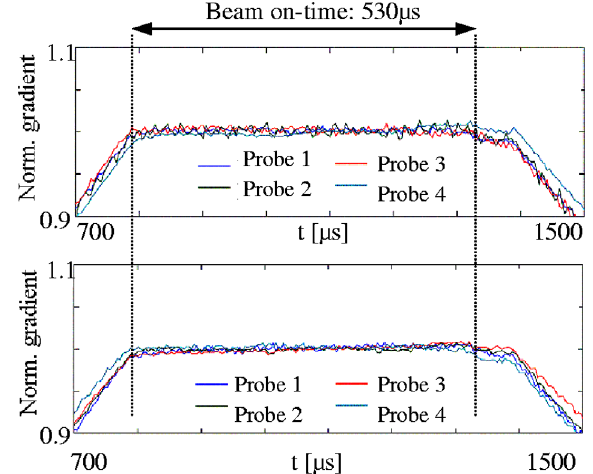
FIG. 6. (Color) Signals from field probes (P1 upper diagram, P2 lower diagram) measured during the acceleration of 530 (cid:6) 1 (cid:15) s at 15 MV = m . bunches, q (cid:6) 4 nC , t b